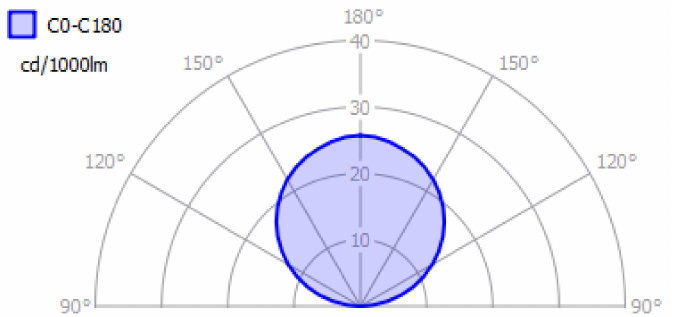
Figure 4. Spatial distribution of the reflected component from outdoor lighting